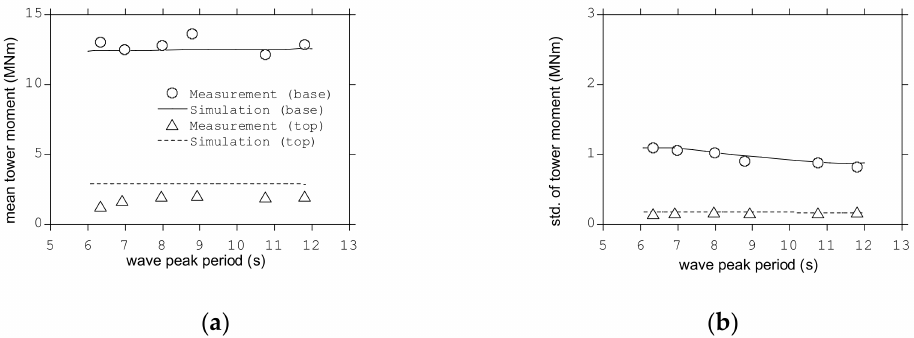
Figure 10. Effect of peak wave period on ( a ) mean and ( b ) standard deviation of fore-aft tower bending moments at the tower top and